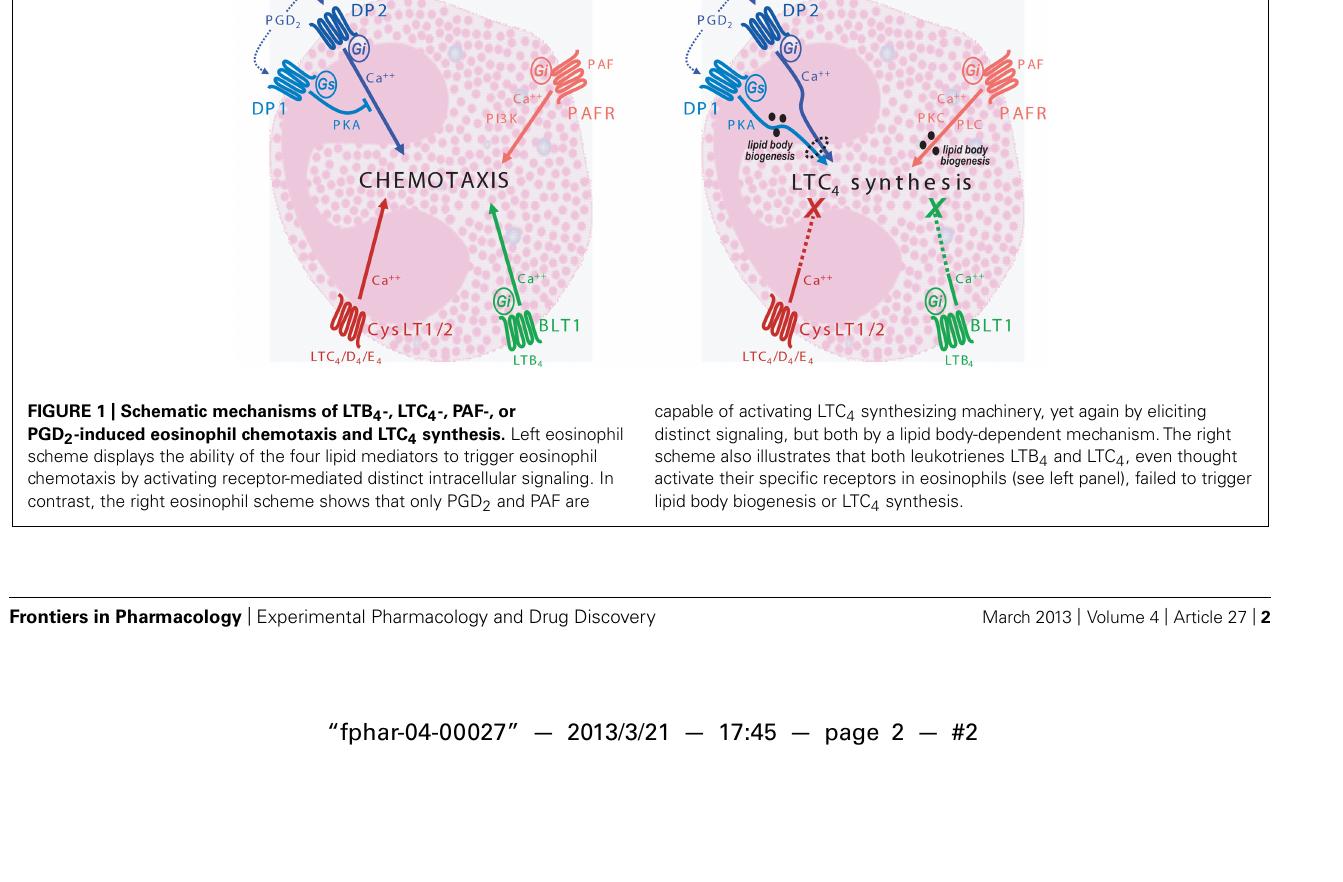
capable of activating LTC 4 synthesizing machinery, yet again by eliciting distinct signaling, but both by a lipid body-dependent mechanism.The right scheme also illustrates that both leukotrienes LTB 4 and LTC 4 , even thought activate their specific receptors in eosinophils (see left panel), failed to trigger lipid body biogenesis or LTC 4